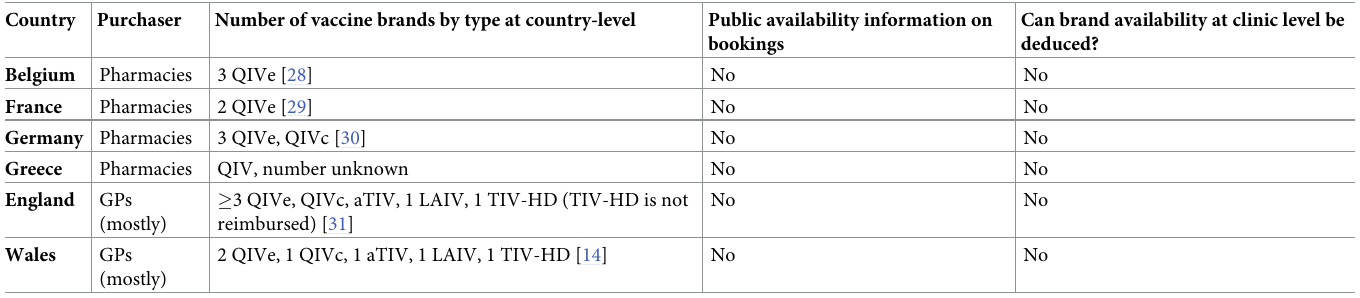
Table 3. Vaccine types and number of brands available in countries with vaccine procurement by pharmacies or GPs (2019–2020 season). Country